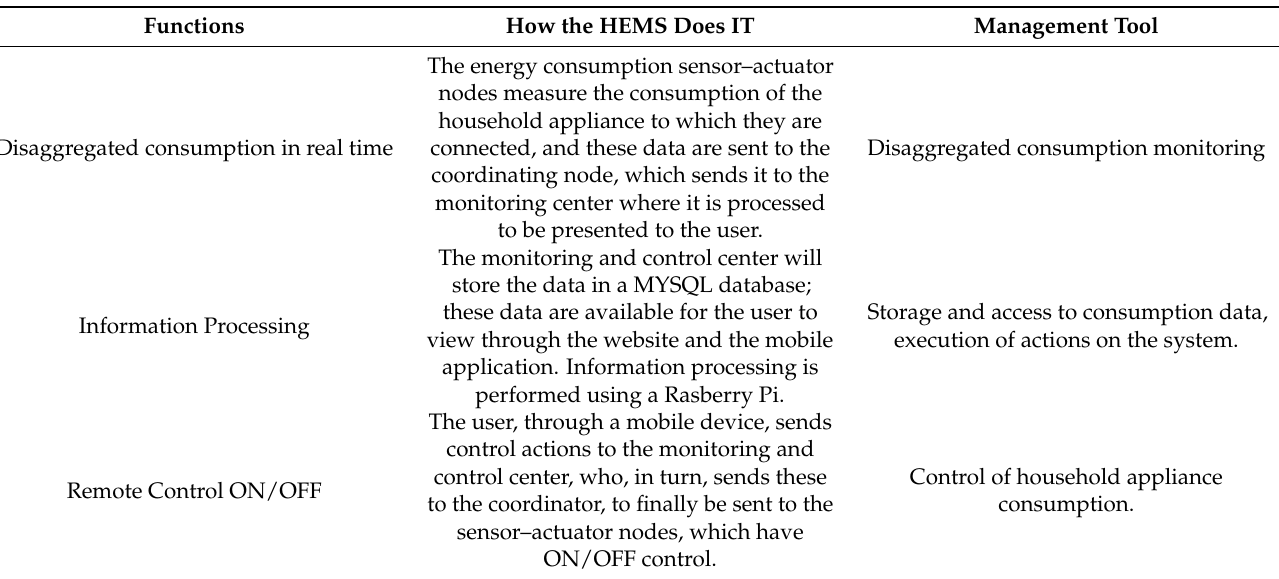
Table 10. Description of system functionality.